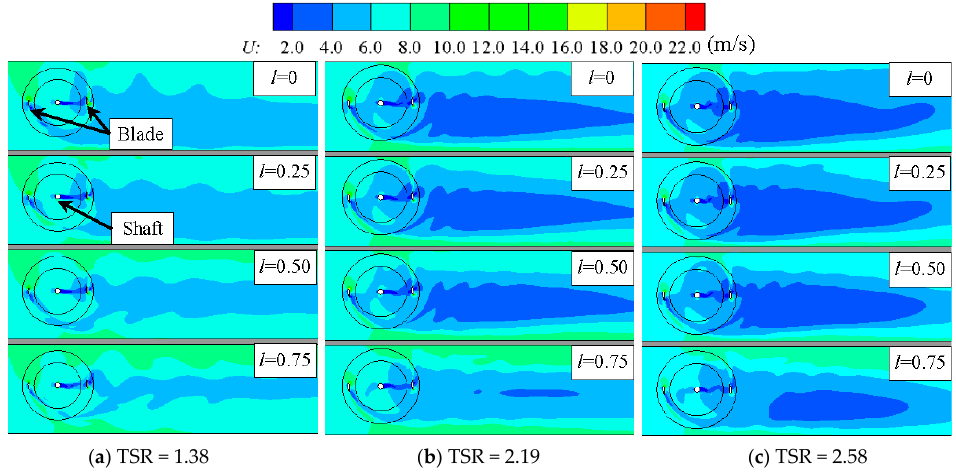
Figure 10. Comparison of contour of wind velocity between the different cross-sections of l = 0, 0.25, 0.50 and 0.75 at three different TSRs with the azimuth angle of θ = 90°: ( a – c ) show the contour of wind velocity of TSR = 1.38, 2.19 and 2.58, respectively.